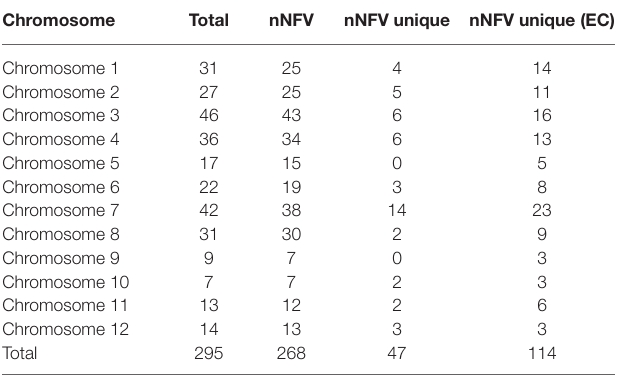
TABLE 1 | Large grain size associated haplotypes (LGHs) distributions across the chromosomes of the Thai rice panel. Column names indicate: “Total”—LGHs identified across all accessions; “nNFV”—number identified among NFVs; “nNFV unique”—number identified uniquely among NFVs; “nNFV unique (EC)”—number identified among NFVs but not among